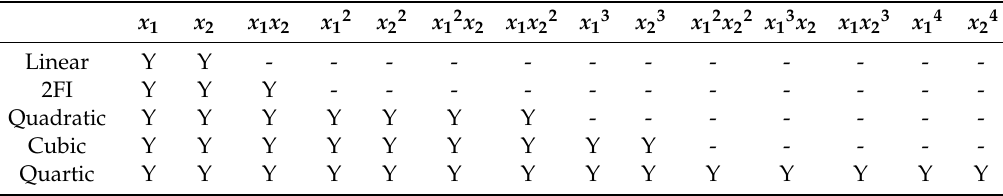
Table 1. Combination of variables in model